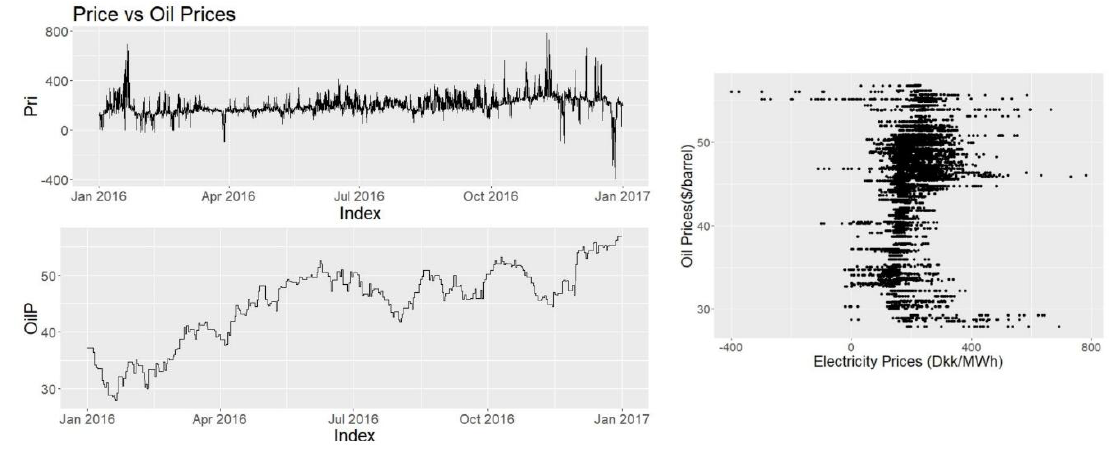
Figure 12. Price vs. Oil prices.